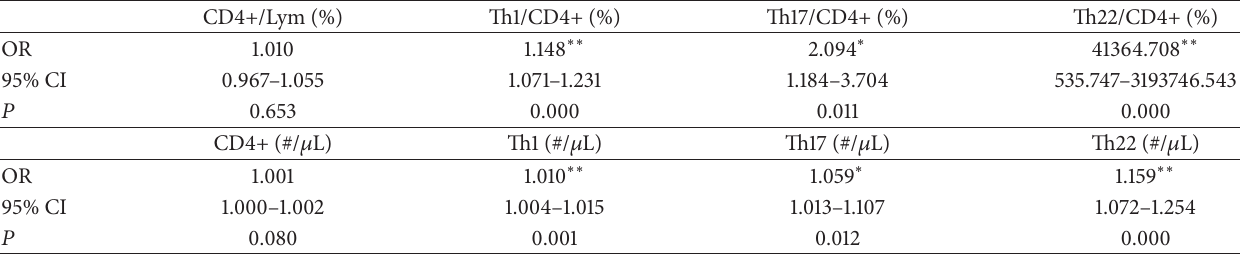
Table 3: Logistic regression analysis of contribution of specific Th subsets to CHD.